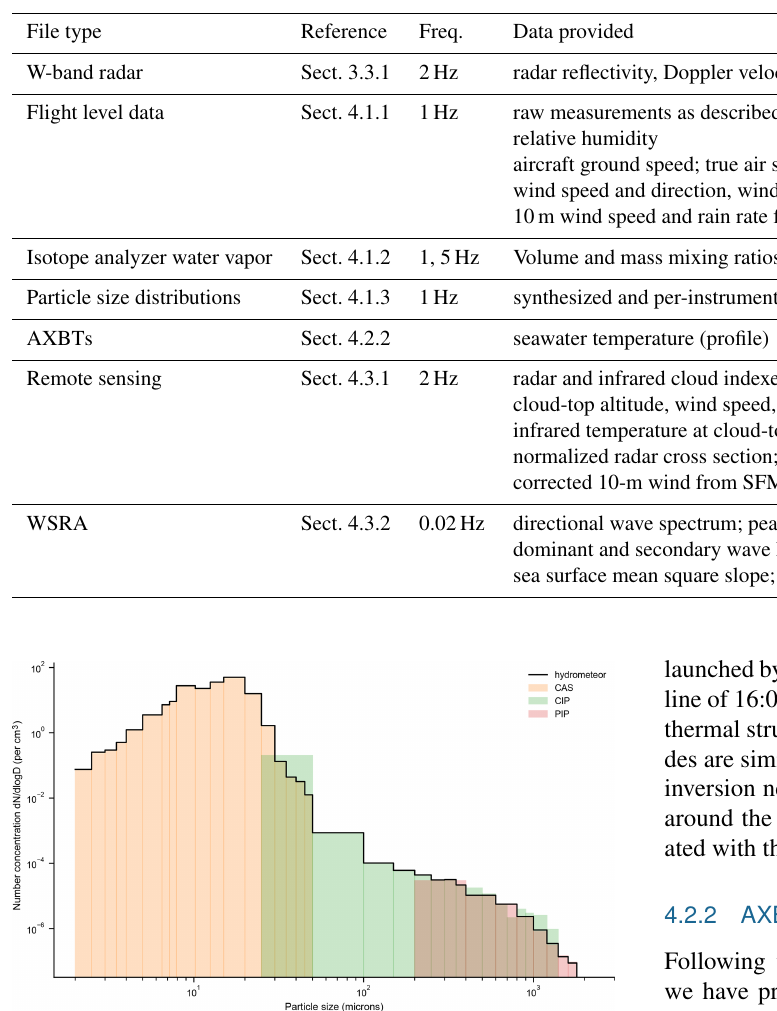
Table 3. Data available from the P-3 during ATOMIC. Data are packaged as one file per type per flight day. Subsections within Sect. 4